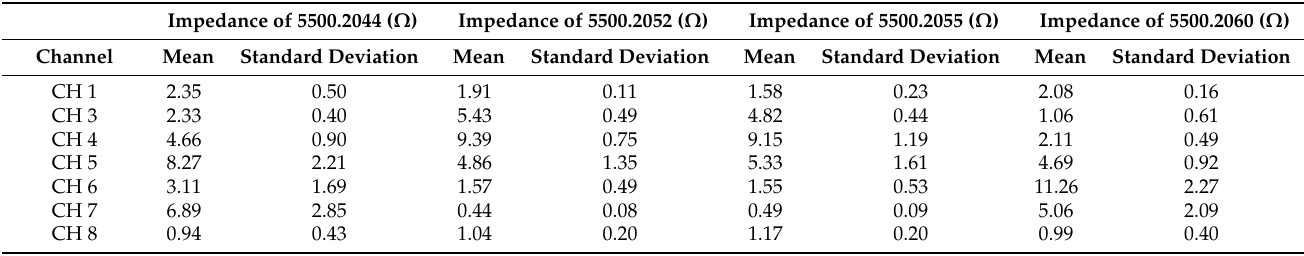
Table 3. Mean and standard deviation of the impedance measured when EMC filters are connected to the setup, without connecting a load in L’-N’.